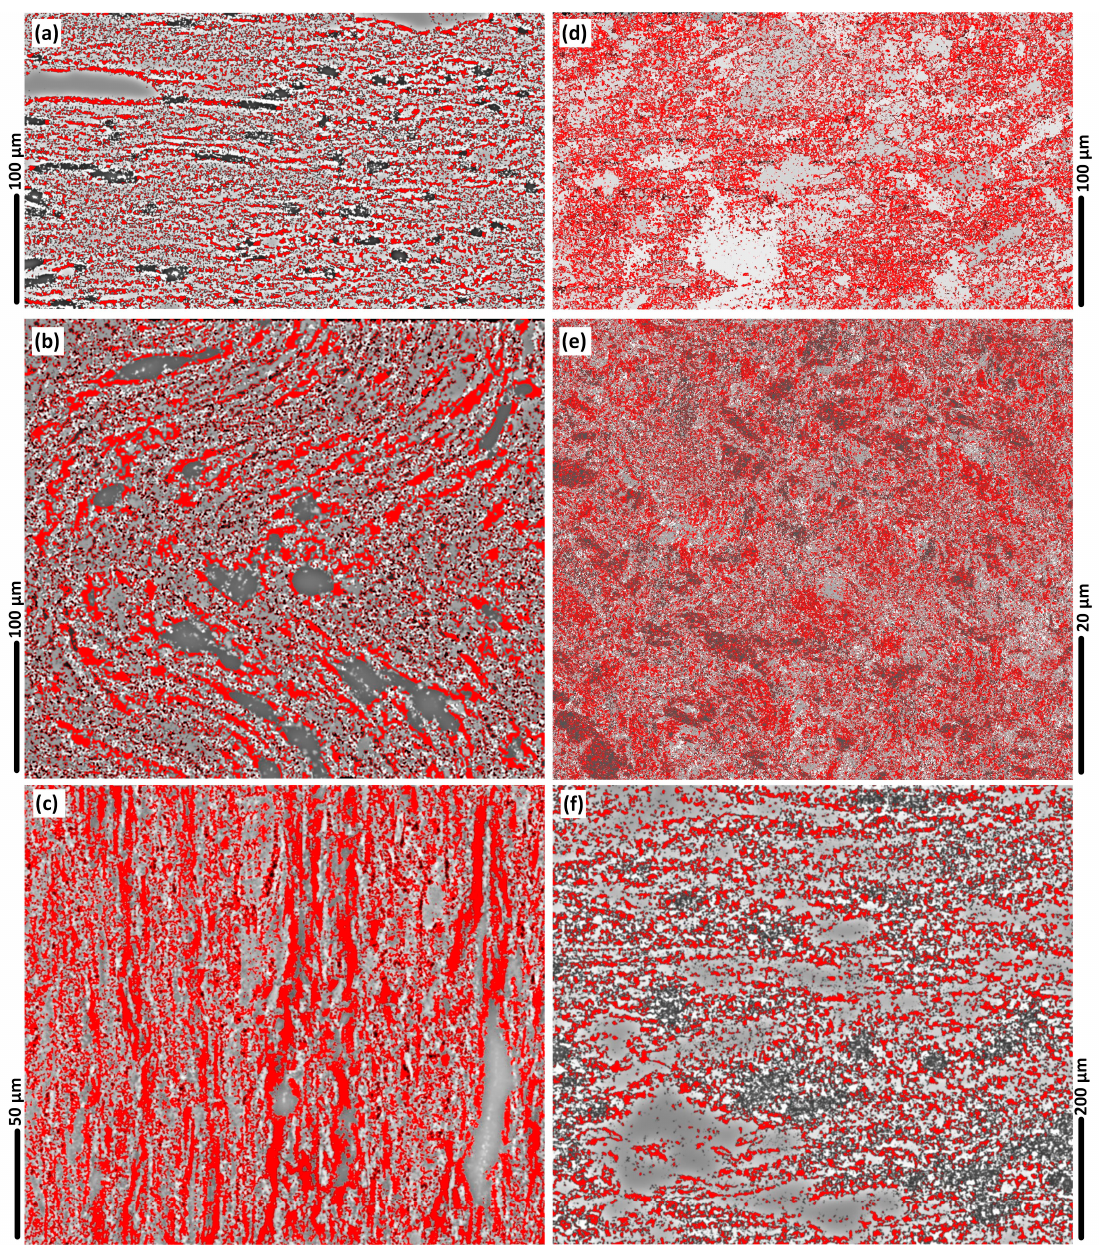
Figure 11. The micropatterns of the presence of high-angle grain boundaries (HAGBs, more than 10°) ( a – f ) in red colour, for different regions of the weld; BM ( a ); AS Hourglass border ( b ); Flow-arms ( c ); Sub-shoulder region ( d ); Mid-SZ ( e ); RS Hourglass border ( f ).